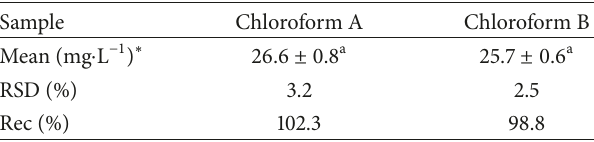
Table 6: Robustness results for analyses with different brands of